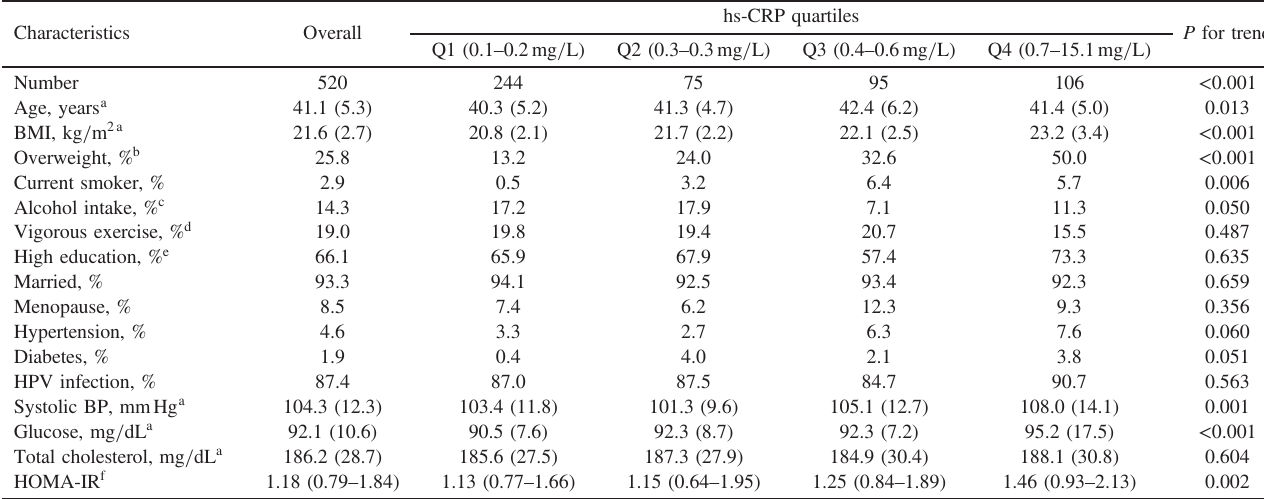
Table 1. Baseline characteristics of study participants by hs-CRP level Characteristics Overall